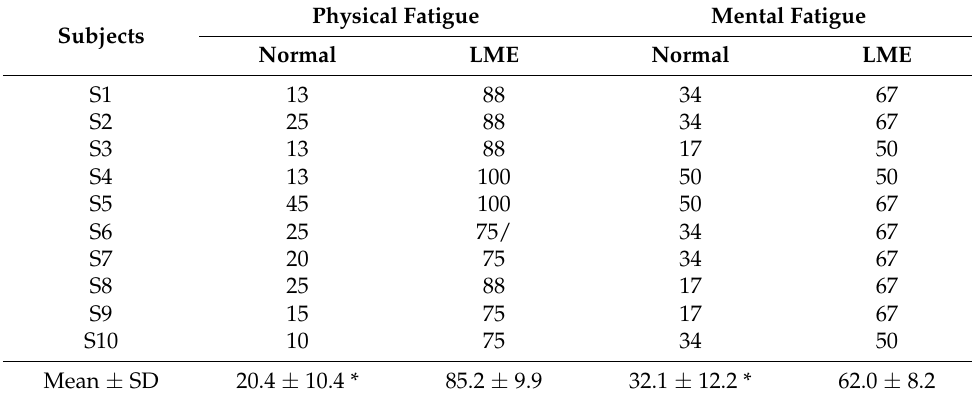
Table 4. Overall Scores from the Fatigue